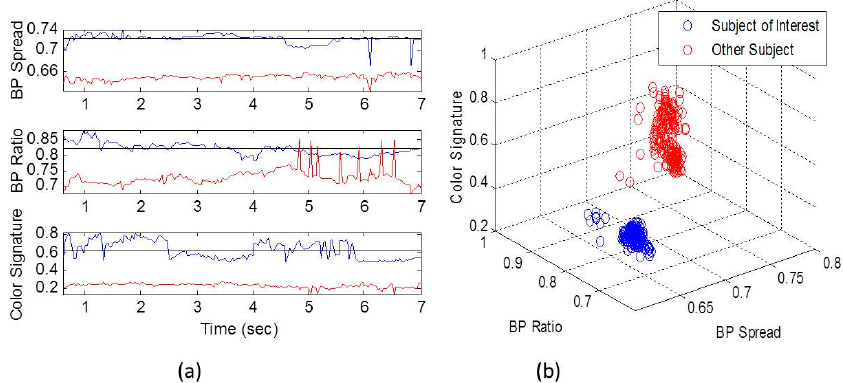
Figure 4. The features in time domain in calibration period ( a ), where the SoI is in blue color, and the other subject is in red color; and in the related feature space ( b ). The two subjects are well separated in both time domain and in feature domain in all the